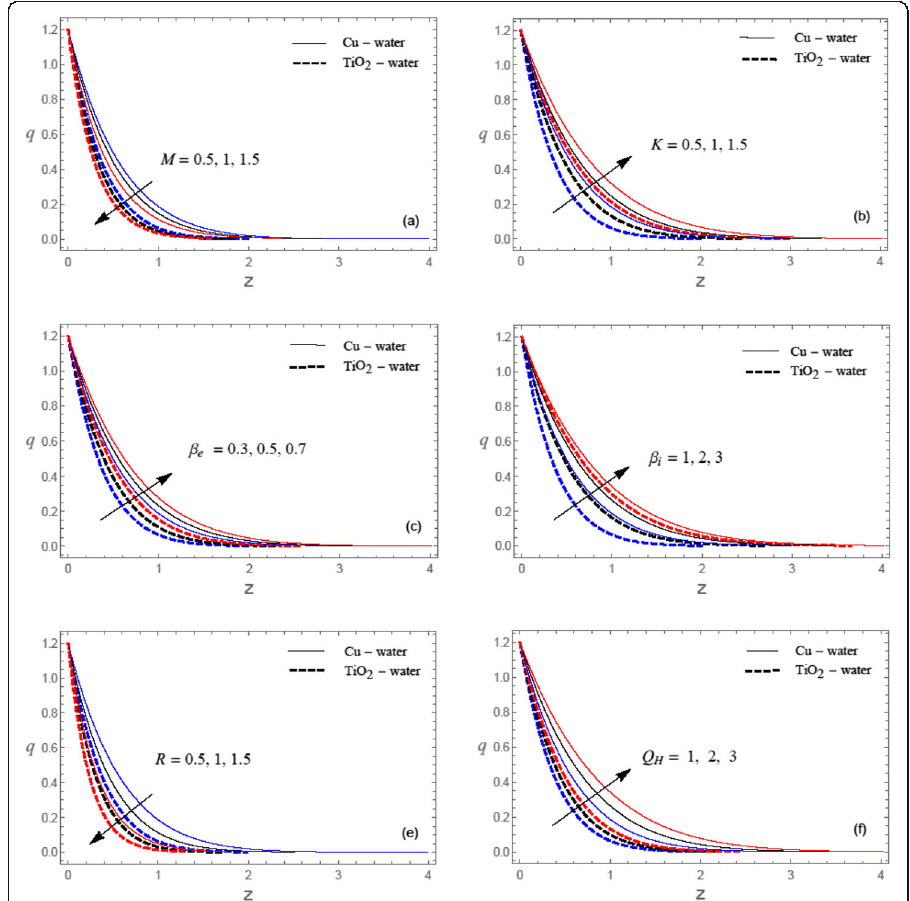
Figure 2f denotes the velocity profile with effect from the heat source parameter Q